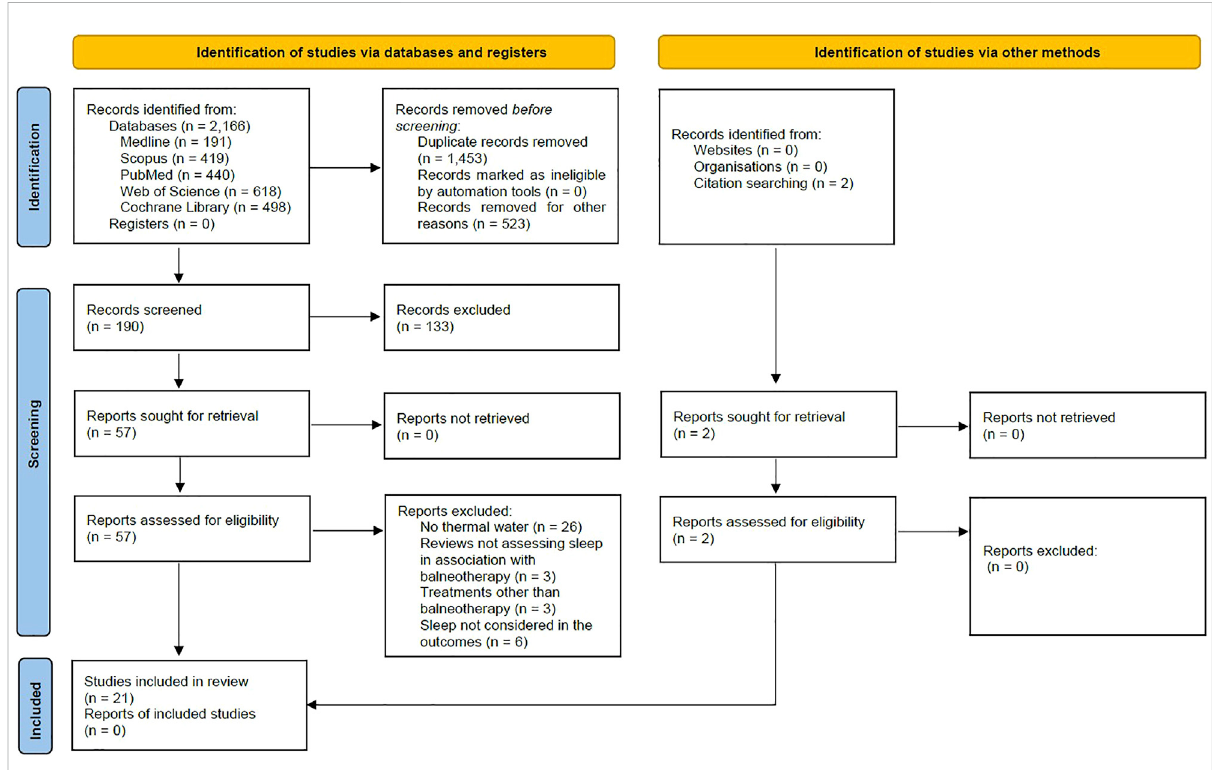
FIGURE 1 PRISMA fl ow diagram of the review (Page et al., 2021). For more information, visit: